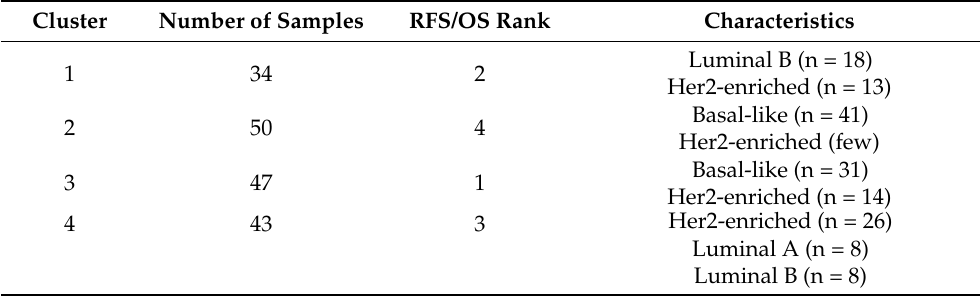
Table 3. Characteristics of four proteome-based clusters found with proteins quantitated in formalin- fixed paraffin-embedded samples obtained from patients diagnosed with breast cancer between 2008–2013 and 1986–1992 [43]. While 9088 proteins were quantified in total, an impressive 4214 pro- teins were quantified in every sample. RFS: recurrence free survival in years; OS: overall survival. Cluster Number of Samples RFS/OS Rank